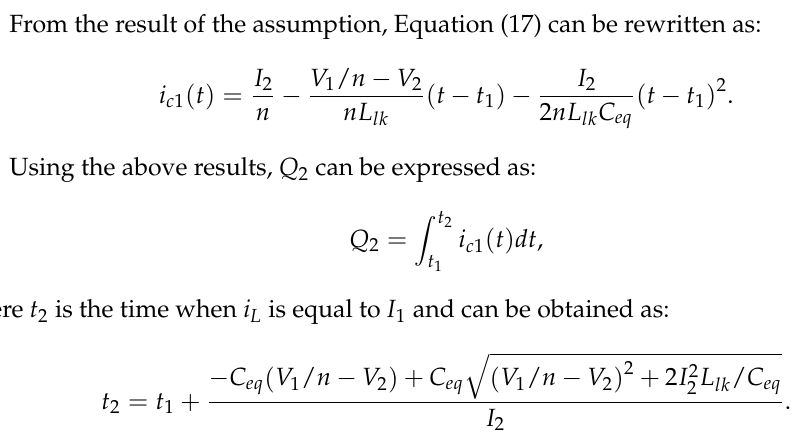
Figure 7. Steady-state waveform of i L in the primary side of the fly-buck converter.